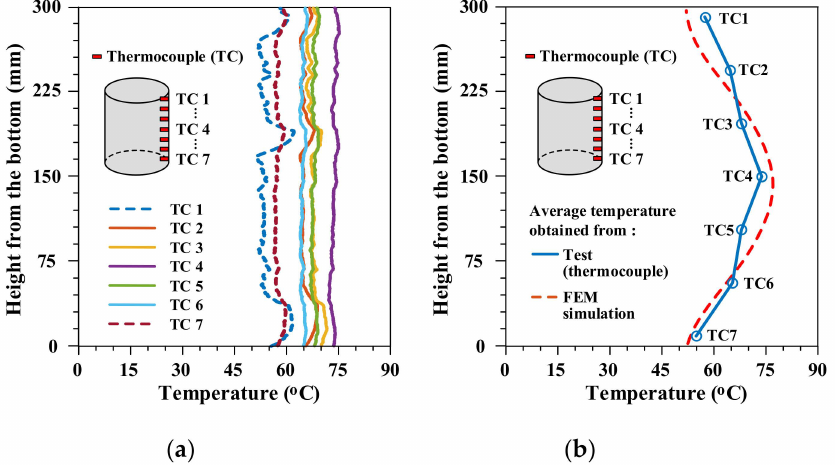
Figure 7. Temperature data: ( a ) of sensors attached to the inner surface of the formwork; ( b ) measured average temperature